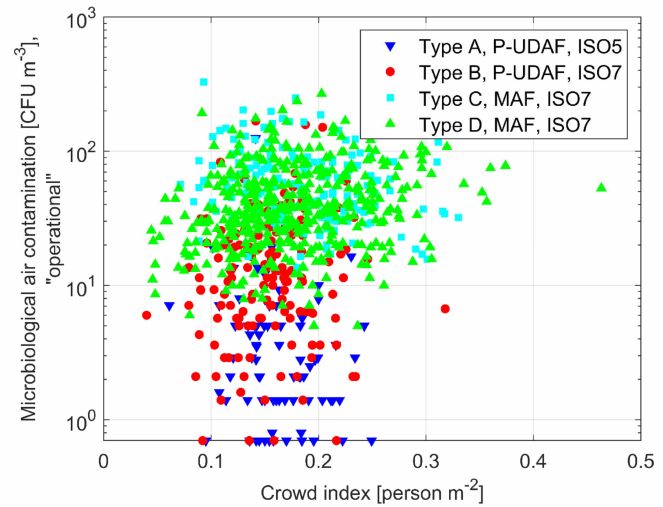
Figure 5. Average microbiological air contamination vs. personnel crowd index in “operational” conditions for di ff erent ventilation systems. Values for 175 investigated